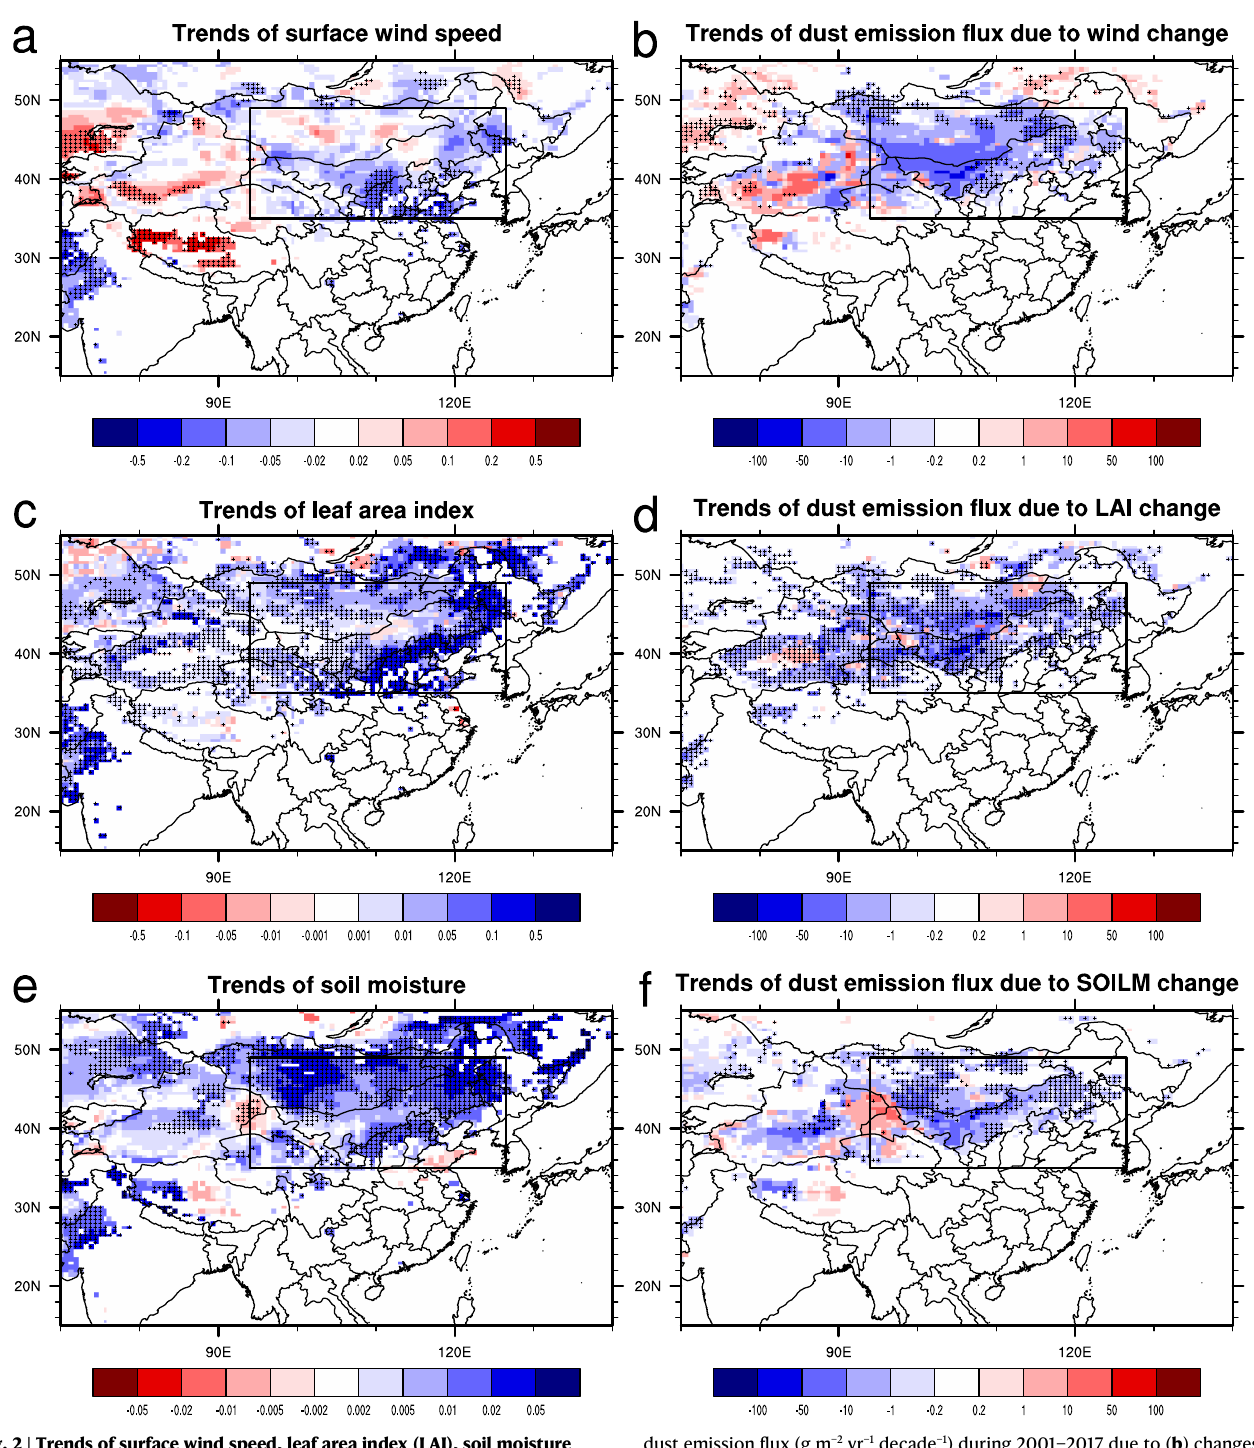
dust emission fl ux (g m − 2 yr − 1 decade − 1 ) during 2001 − 2017 due to ( b ) changes of surface wind speed (Wind), ( d ) leaf area index (LAI), and ( f ) soil moisture (SOILM), respectively. The crosses denote the regions where the trends are statistically signi fi cant( p <0.1).Theblackrectangledenotesthe EasternSources (35-49 °N, 94 − 126.5